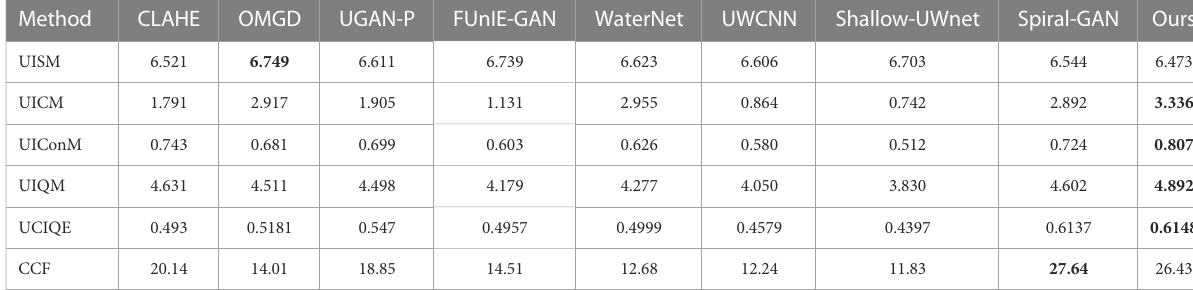
The bold indicates the best scores.